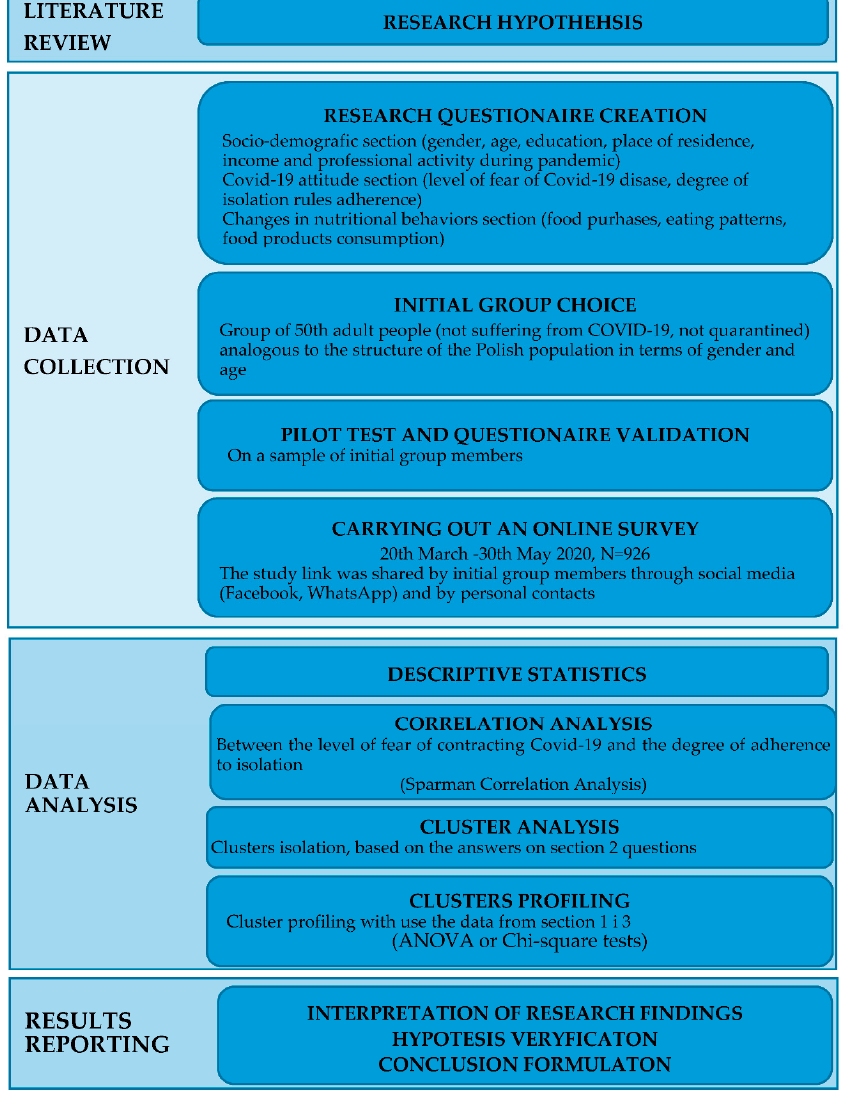
Figure 1. Research conception and methodology.